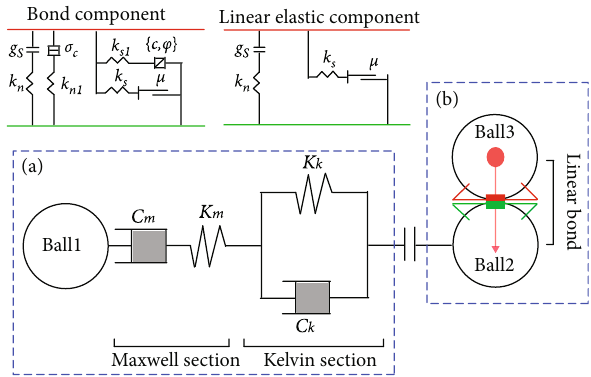
Figure 1: A combinatorial constitutive contact model of Burger and